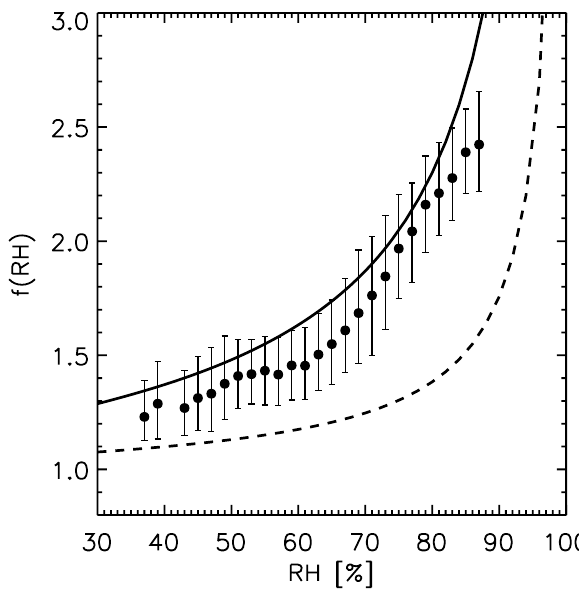
Fig. 10. Composite humidogram of wet nephelometer data recorded in the MBL. Filled circles are the median and the error bars the up- per and lower quartiles of 1Hz data gridded in 2% RH bins. A the- oretical curve for ammonium sulphate is plotted as a solid black line for reference and a dashed line illustrates a growth curve more typical of that observed in European pollution over the